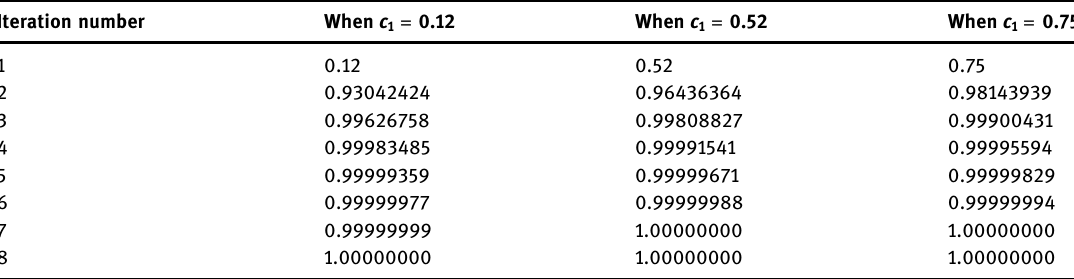
Table 2: Values of iteration for di ff erent initial